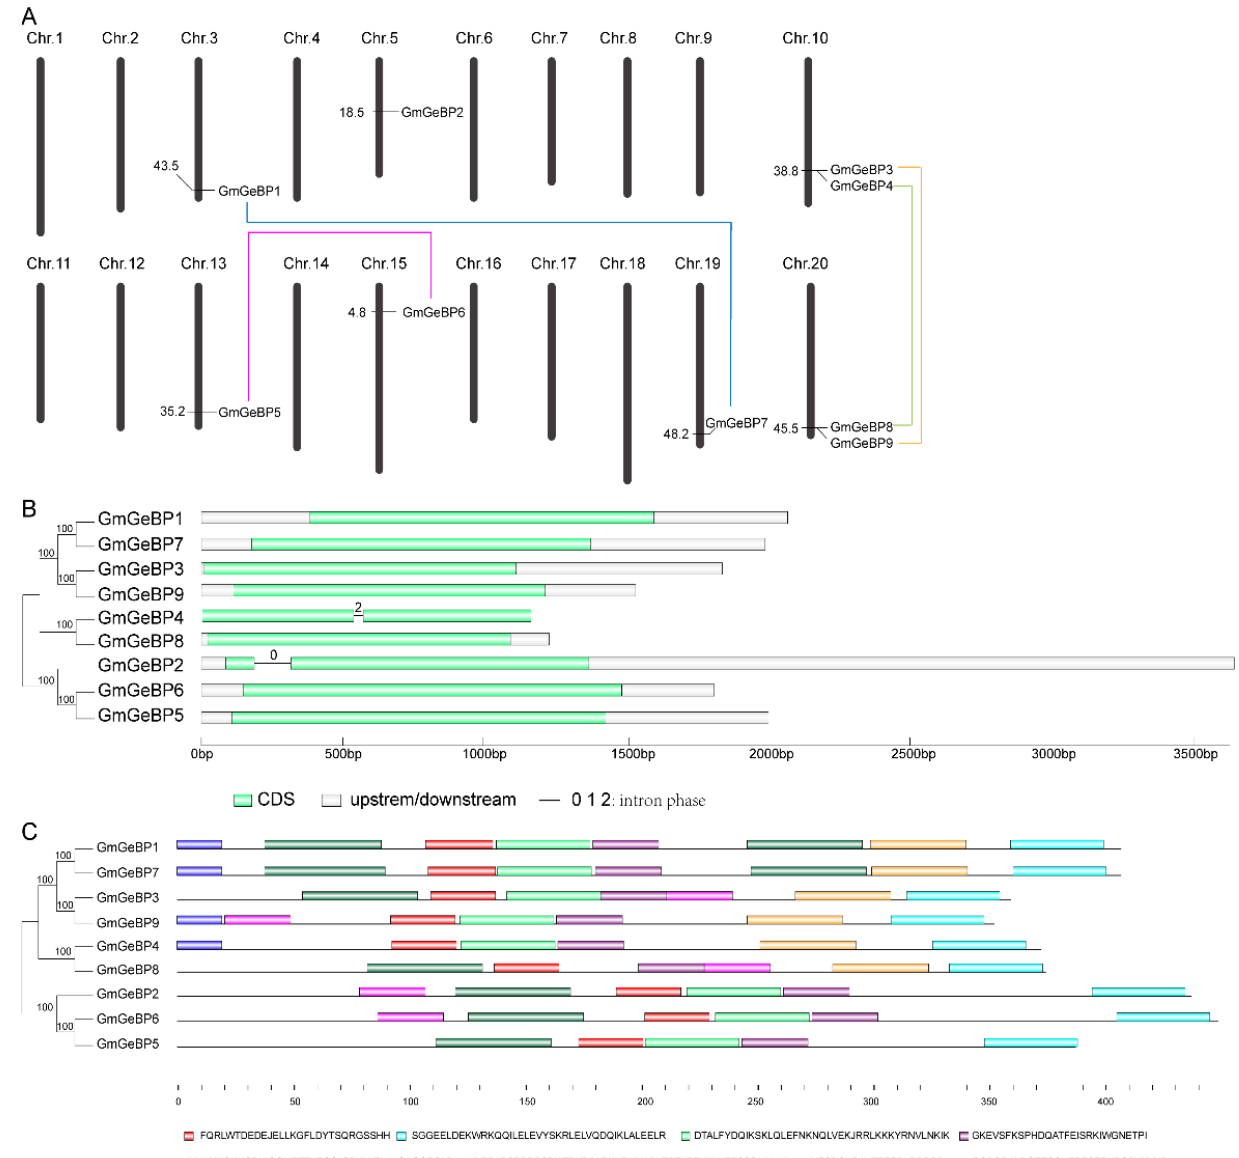
Figure 1. Characteristics of GmGeBP genes. ( A ) Chromosomal map and gene duplication events of GmGeBPs . Only the locations of GeBP genes are shown in the map. The segment duplication events are marked by different colored dotted lines. ( B ) Gene structures of GmGeBP genes. The unrooted phylogenetic tree consists of 9 GmGeBP genes. The different colored boxes represent different types of motifs. ( C ). Structures of conserved motifs of GmGeBP proteins. The unrooted tree was produced using the MEGA version 11.0 program using the amino acid sequences of all nine GmGeBP members with the neighbor-joining (NJ) method. The boxes in different colors represent the different motifs (the boxes in the first line from left to right represent motifs 1, 2, 3 and 4 and the boxes in the next line from left to right represent motifs 5, 6, 7 and 8) and the name of each motif is displayed on the right of the box. The length of a protein and motif can be measured using the scale at the bottom.